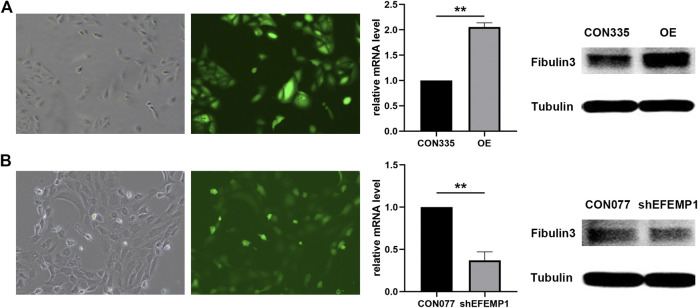

(A) EFEMP1 overexpressing (EFEMP1-OE) and (B) EFEMP1 knockdown HUVEC establishment and verification. High-content imaging visualization of HUVECs transfected with GFP-labelled GV492-EFEMP1/GV248-shEFEMP1 vectors was shown. qRT-PCR results of EFEMP1 relative mRNA levels showed a significant increase in GV492-EFEMP1-transfected HUVECs compared with that in GV492-CON335-transfected HUVECs and a significant decrease in GV248-shEFEMP1-transfected HUVECS compared with that in GV492-CON077-transfected HUVECs (**p < 0.01). EFEMP1 protein levels in the four HUVEC groups were tested using western blotting. EFEMP1 protein expression in GV492-EFEMP1-transfected HUVECs increased significantly compared with that in control CON335 and decreased in GV248-shEFEMP1-transfected HUVECS compared with that in control CON077 (**p < 0.01).